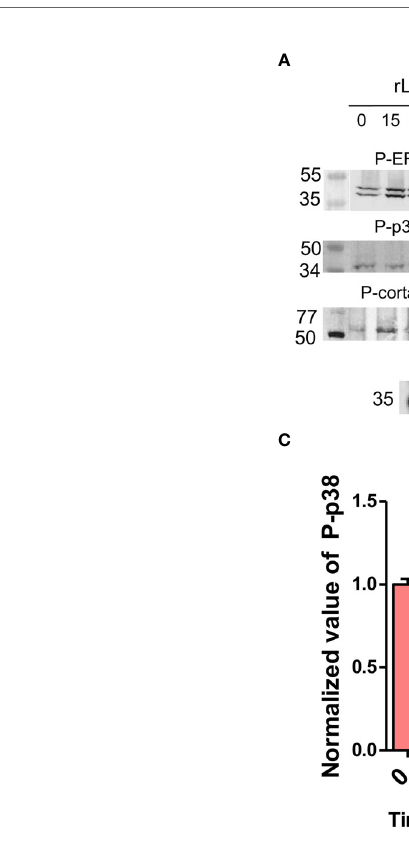
FIGURE 6 | LdMVK induces the phosphorylation of RAW 264.7 cell signaling proteins. (A) Western blot of rLdMVK induced time dependent phosphorylation of RAW cell lysate probed with Phospho-ERK-1/2, ERK-1/2, Phospho-p38 MAP kinase, p-38 MAP kinase, Phospho-cortactin, cortactin, and GAPDH. (B) Bar graph representing normalized densitometry values of rLdMVK induced time-dependent phosphorylation of ERK-1/2, with maximum phosphorylation at 15 min. (C) Cortactin shows increased LdMVK-dependent phosphorylation at 15 and 90 min post-induction. (D) Phospho-p38 did not show signi fi cant activation on MVK- induction. 0 min studies served as negative control of experiment, i.e., RAW macrophages without LdMVK incubation. Anti-GAPDH was used as loading control in all the experiments. Band densitometry was performed using ImageJ software. Data are represented as the mean ± SEM of three experiments and blots are representative image of those. For total ERK-1/2, total-p38, and total Cortactin blots, the membrane was stripped and re-probed. p value < 0.05 is denoted by *, p value ≤ 0.01 is denoted by